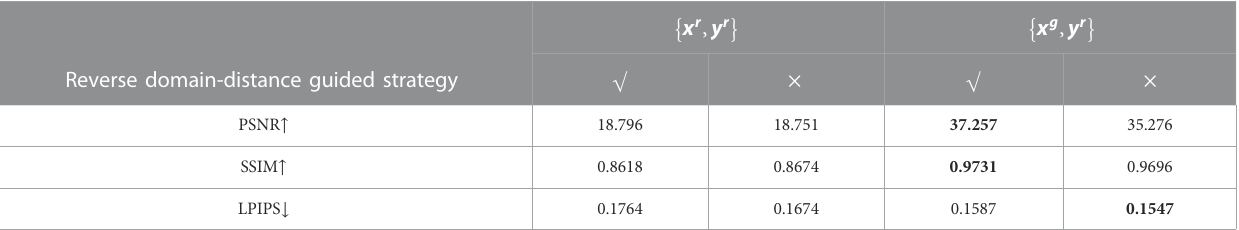
TABLE 2 Ablation studies of Darkening Network and Reverse Domain-Distance Guided strategy with the settings of both pseudo-LL-NL pairs and GT LL-NL pairs from the existing dataset.